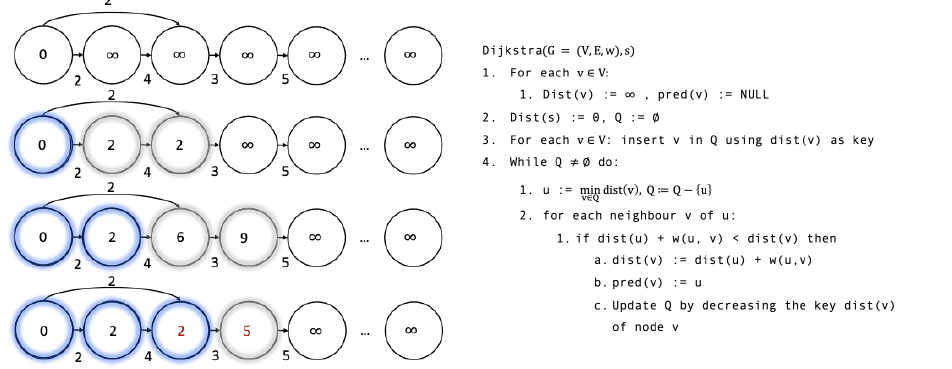
Figure 2. A conceptual representation of the shortest-path similarity update with the test sequence X (pseudo-code on the